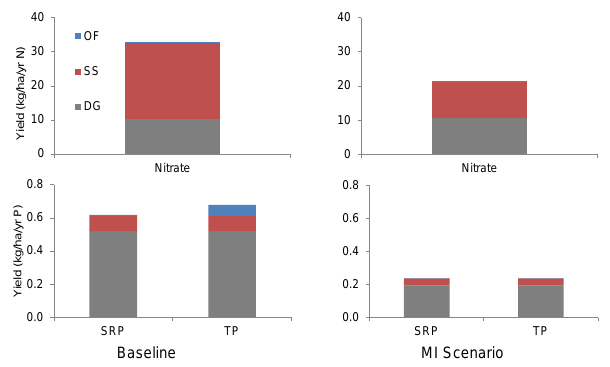
Figure 7. Comparison of the nutrient yields (N and P) from the baseline (left) and MI scenario